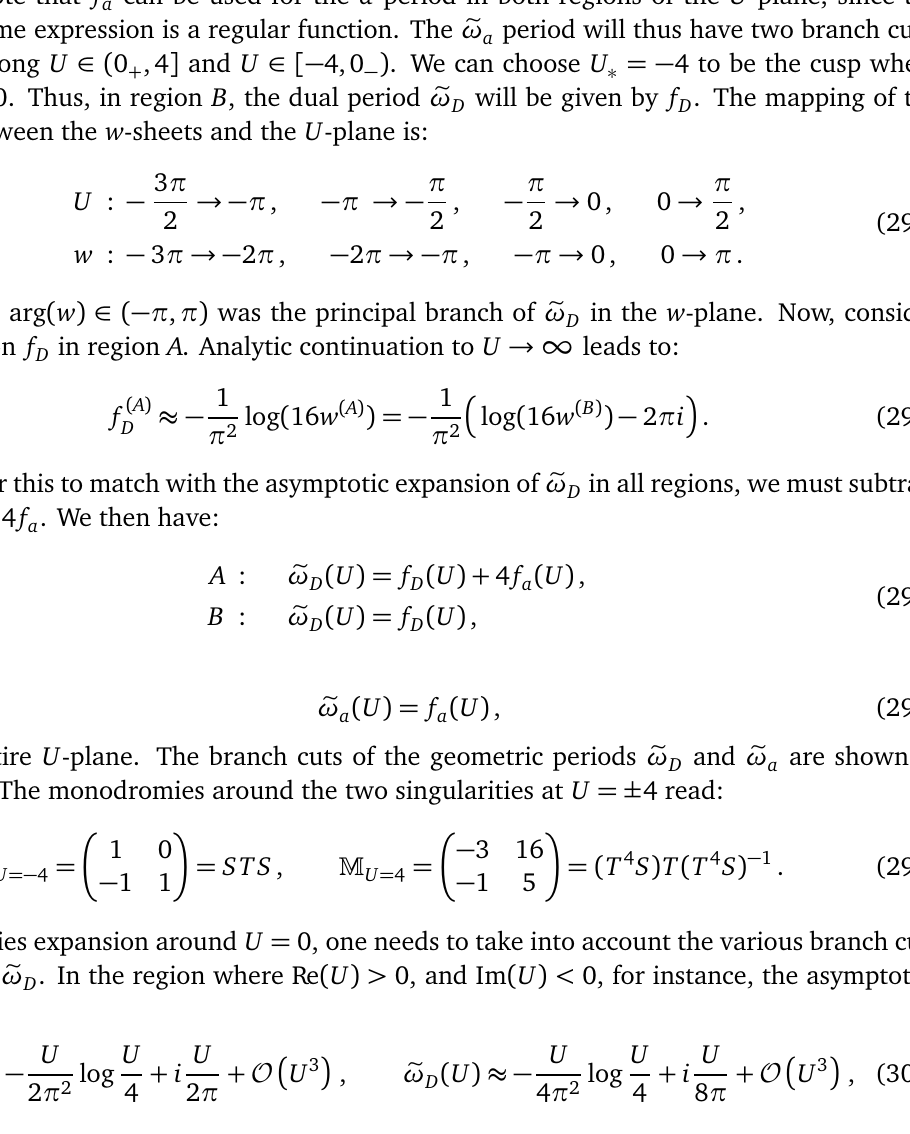
ω ( U ) and (cid:101) D